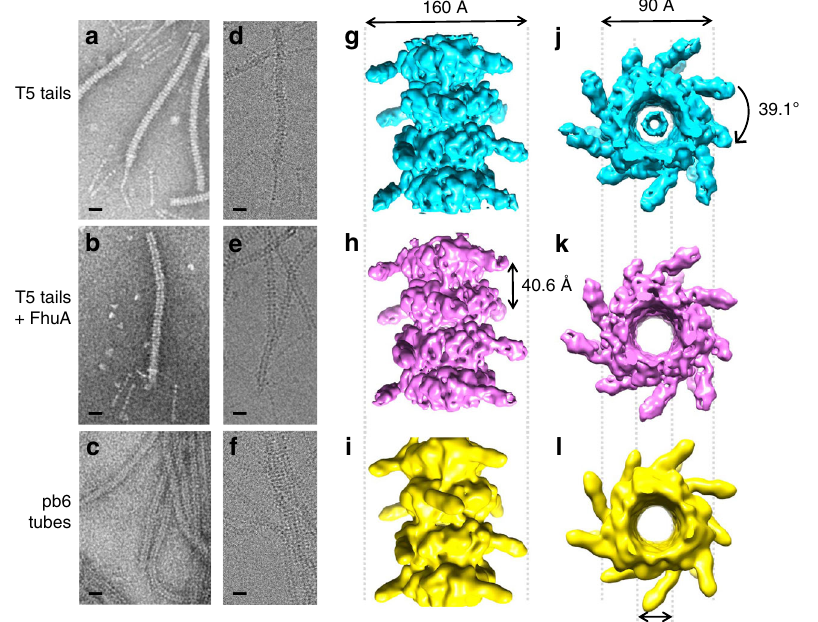
Fig. 2 EM reconstructions of T5 tail before and after interaction with FhuA. Negative stain ( a , b , c ) and cryo-EM ( d , e , f ) images, and cryo-EM 3D reconstruction (side views ( g , h , i ) and top view ( j , k , l )) of T5 tails before (6.2 Å resolution, a , d , g , j ) and after (5.8 Å resolution, b , e , h , k ) interaction with FhuA, and of pb6 tubes (8.8 Å resolution, c , f , i , l ). Scale bar, 20 nm